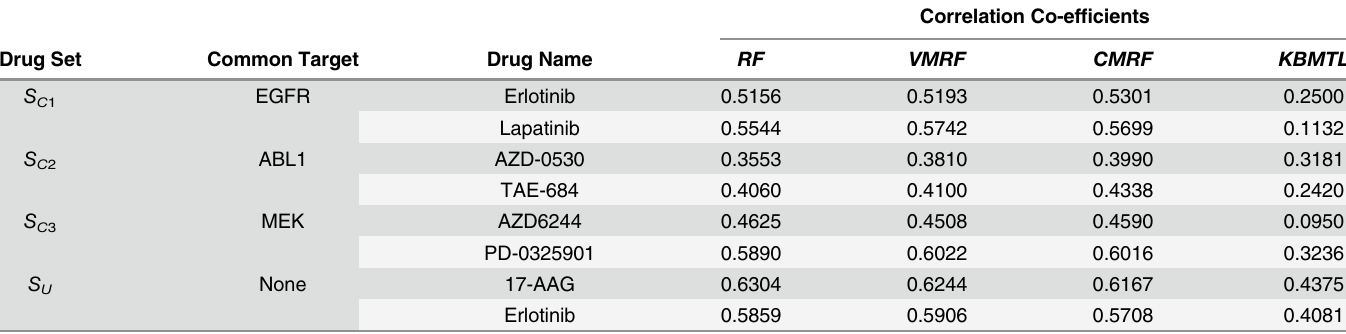
Table 3. 5 fold CV results for GDSC Dataset drug sensitivity prediction for four drug sets in the form of correlation coefficients. VMRF , CMRF repre- sent Multivariate Random Forest using Covariance and Copula respectively. KBMTL represents Kernelized Bayesian multitask learning (Parameters consid- ered are 200 iterations, α = β = 1 and subspace dimensionality = 20).